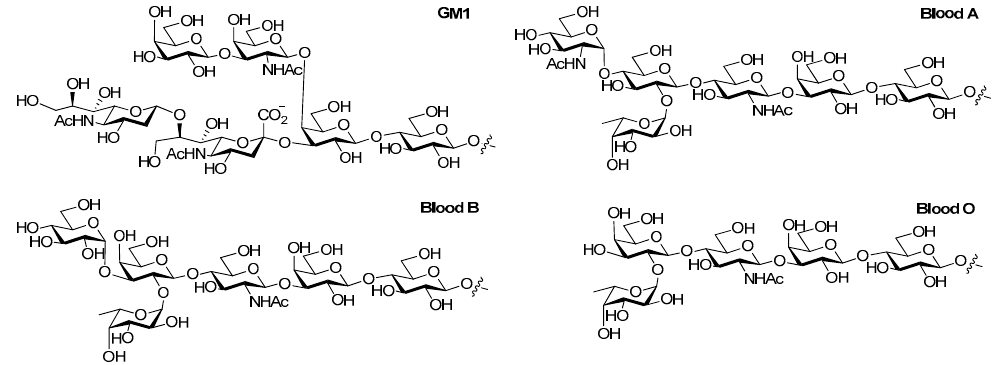
Figure 13. Examples of oligosaccharides synthesized with automated enzymatic synthesis where GM1 is a well-known ganglioside, and the antigens of blood types A, B, and O. Alternatively, substrate bound solid-phase synthesis strategies also received attention [240,241].